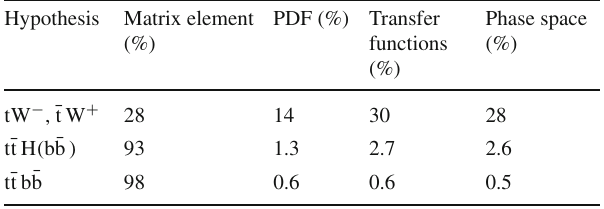
Table 4 Indicative shares of computation time due to the various ele- ments entering the evaluation of weights under different hypotheses. The elements shown are the evaluation of the matrix element, the par- ton distribution functions, the transfer functions, and the generation of the phase space (including the changes of variables introduced in Sect. 3) Hypothesis Matrix element